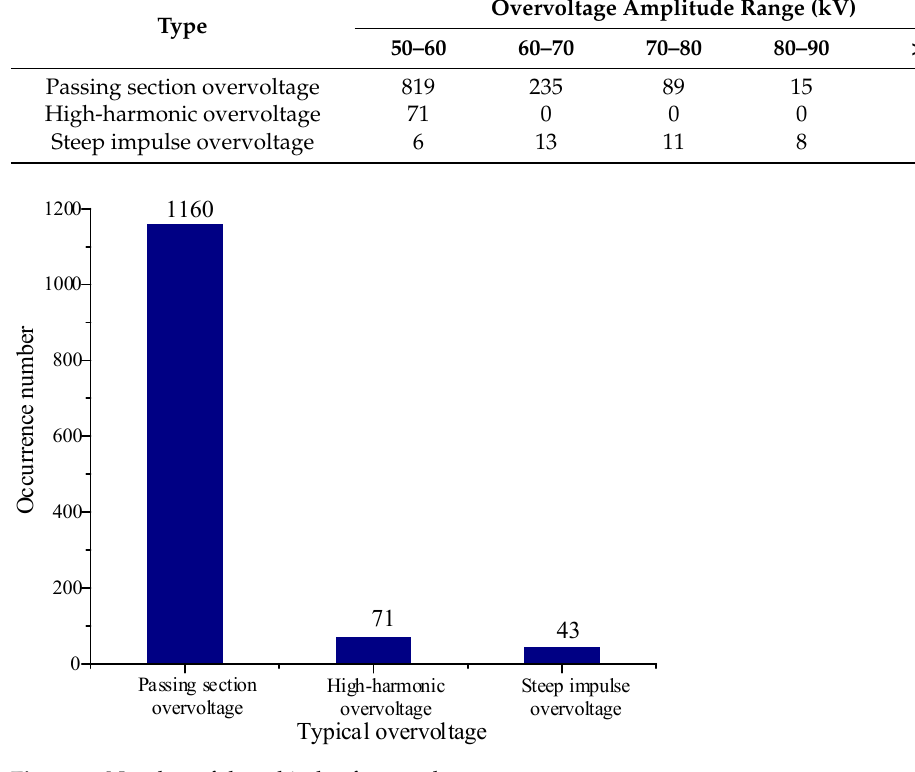
Figure 9. Number of three kinds of